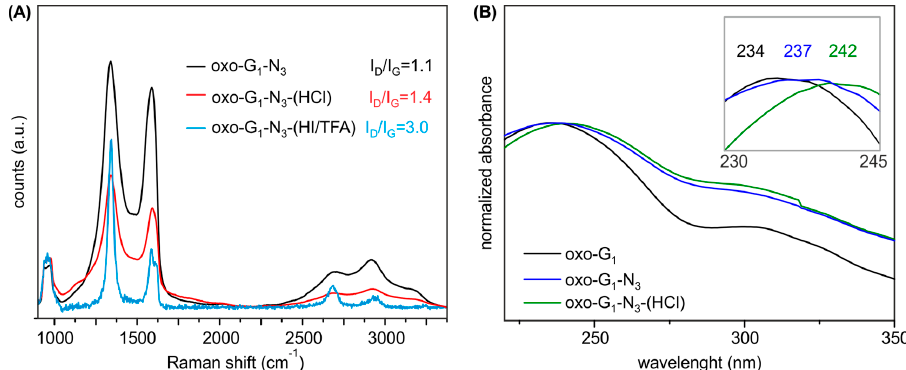
Figure 3. ( A ) UV-Vis spectra of oxo-G 1 in water, oxo-G 1 -N 3 and oxo-G 1 -N 3 -(HCl) in a 1/1 mixture of water/2-propanol. ( B ) Mean Raman spectra of films (on SiO 2 /Si wafer) of oxo-G 1 -N 3 , compared to oxo-G 1 -N 3 treated with HCl and HI/TFA, respectively (measurement of the same area before and after treatment of oxo-G 1 -N 3 ).